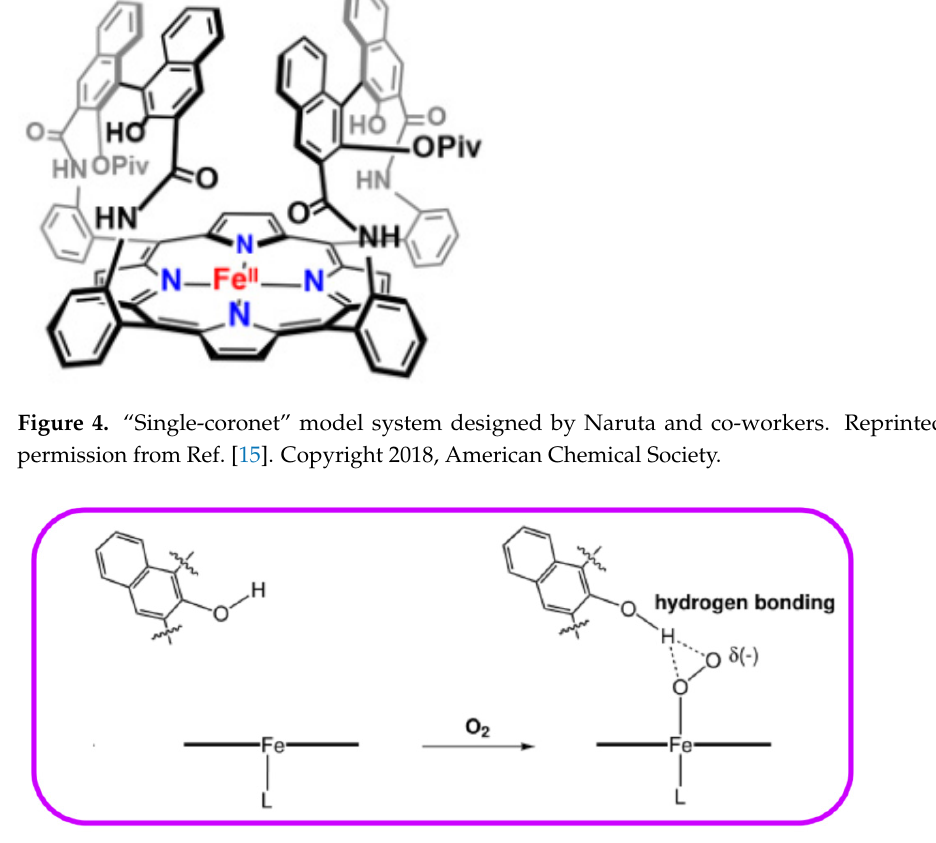
Figure 5. Stabilization of Fe-O 2 species through hydrogen-bonding interactions resulting from hydroxylated naphthyl functionalities in “coronet” model systems. Reprinted with permission from Ref. [90]. Copyright 2003, WILEY-VCH Verlag GmbH.